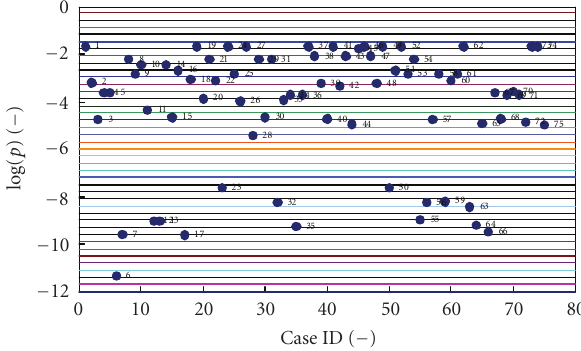
Figure 20: Characterization of system status on the basis of the probability. Six system status (1 to 6 in the figure) is determinis- tically derived and sixty-nine (7 to 75 in the figure) are statistically derived assuming a continuous probability